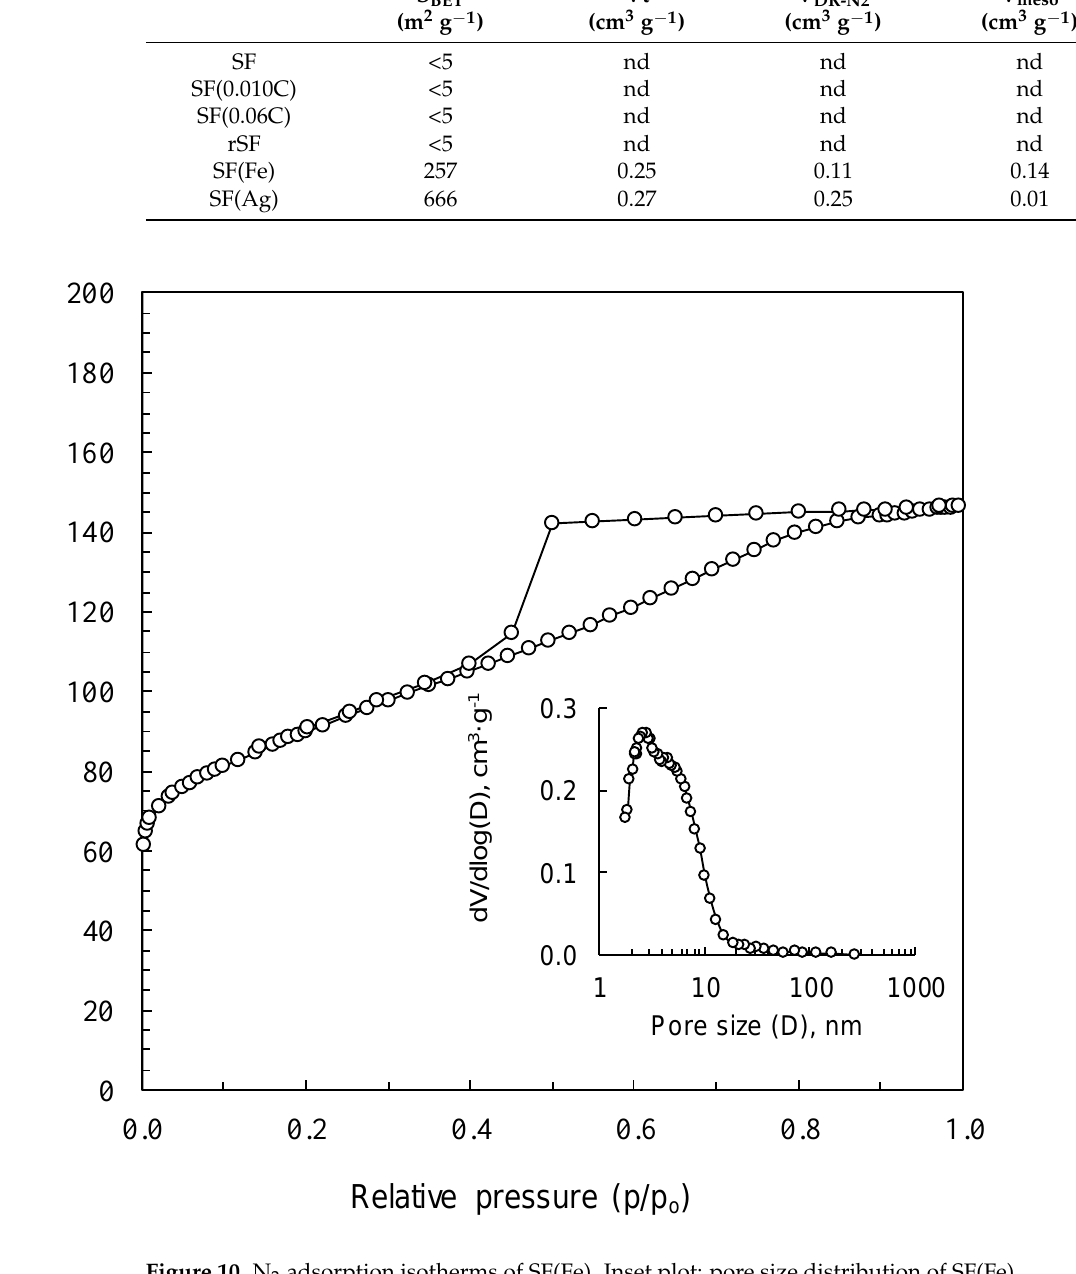
Figure 10. N 2 adsorption isotherms of SF(Fe). Inset plot: pore size distribution of SF(Fe). These results confirm a different behaviour of iron and silver nitrates when the green foams are carbonized at 900 ◦ C. As already described, the decomposition of silver and iron species during carbonization results in the formation of Ag in its free state and mainly in metal oxides in the case of Fe, generating porosity by activation in the process. In the case of iron nitrate, it has been proposed that not only the carbonization catalyzed by iron oxides generates mesopores, but the particles formed can act as a template to create more mesopores [29,47]. Conversely, the presence of free-state silver in SF(Ag) seems to generate different activation characteristics, giving rise to microporosity